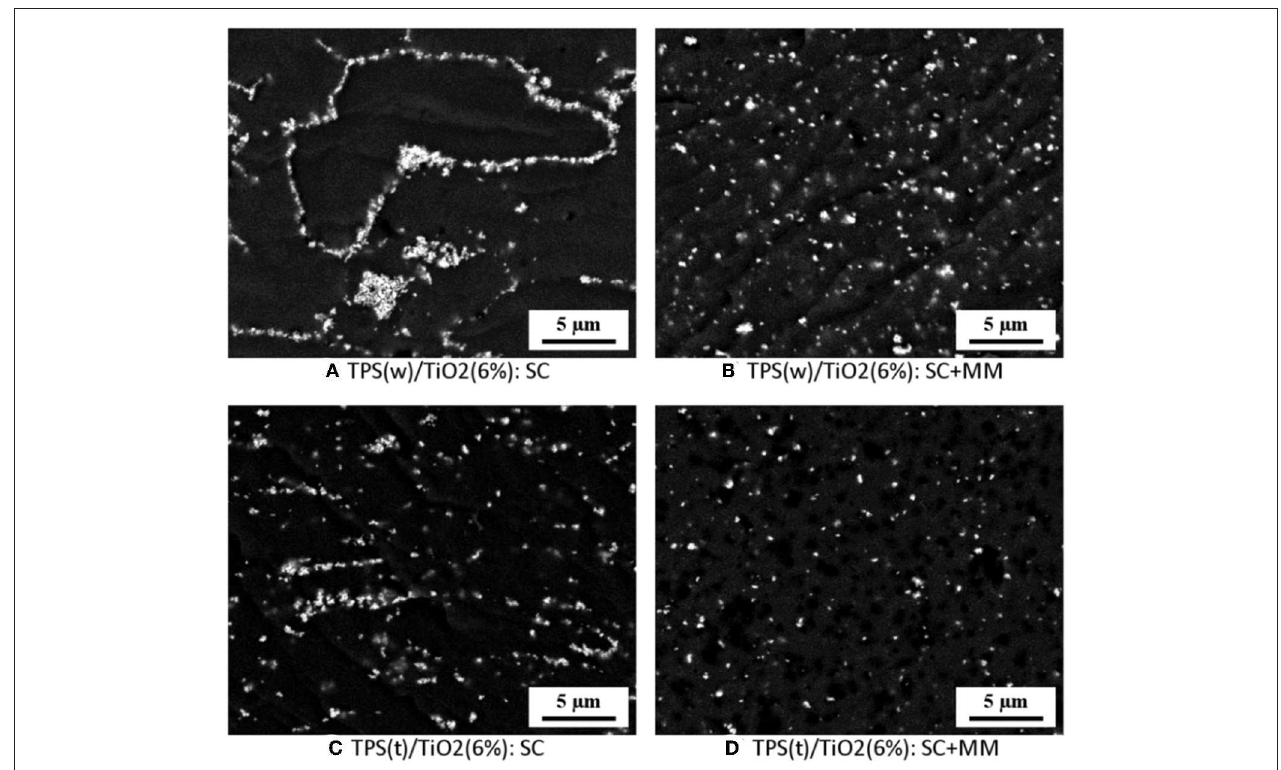
FIGURE 2 | SEM/BSE micrographs showing TPS/TiO 2 (6%) composites: (A,B) wheat starch composite TPS(w)/TiO 2 (6%) and (C,D) tapioca starch composite TPS(t)/TiO 2 (6%); left column (A,C) shows composites after solution casting and right column (B,D) shows composites after solution casting and melt mixing.